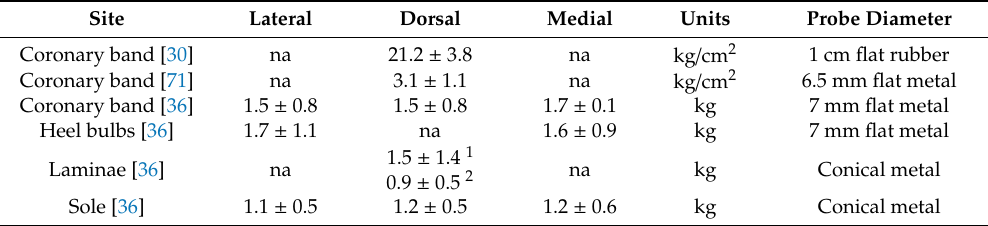
Table 11. Mean MNTs at di ff erent regions within the digit.